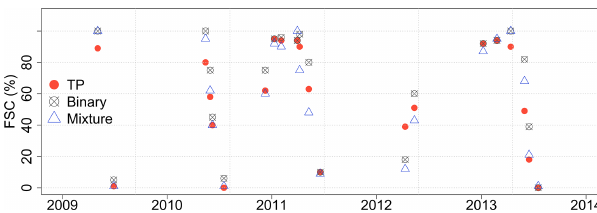
Figure 9. Comparison between the observed fractional snow cover (FSC) evolution (2009–2014) in the camera C2 scene area from the Guadalfeo Network (TP, red dots) and the estimated value from two different retrieval algorithms based on Landsat TM data: a binary approach (snow–no snow) and a fractional approach from a spec- tral mixture algorithm (FSC in every pixel of the satellite image). Adapted from Pimentel et al.